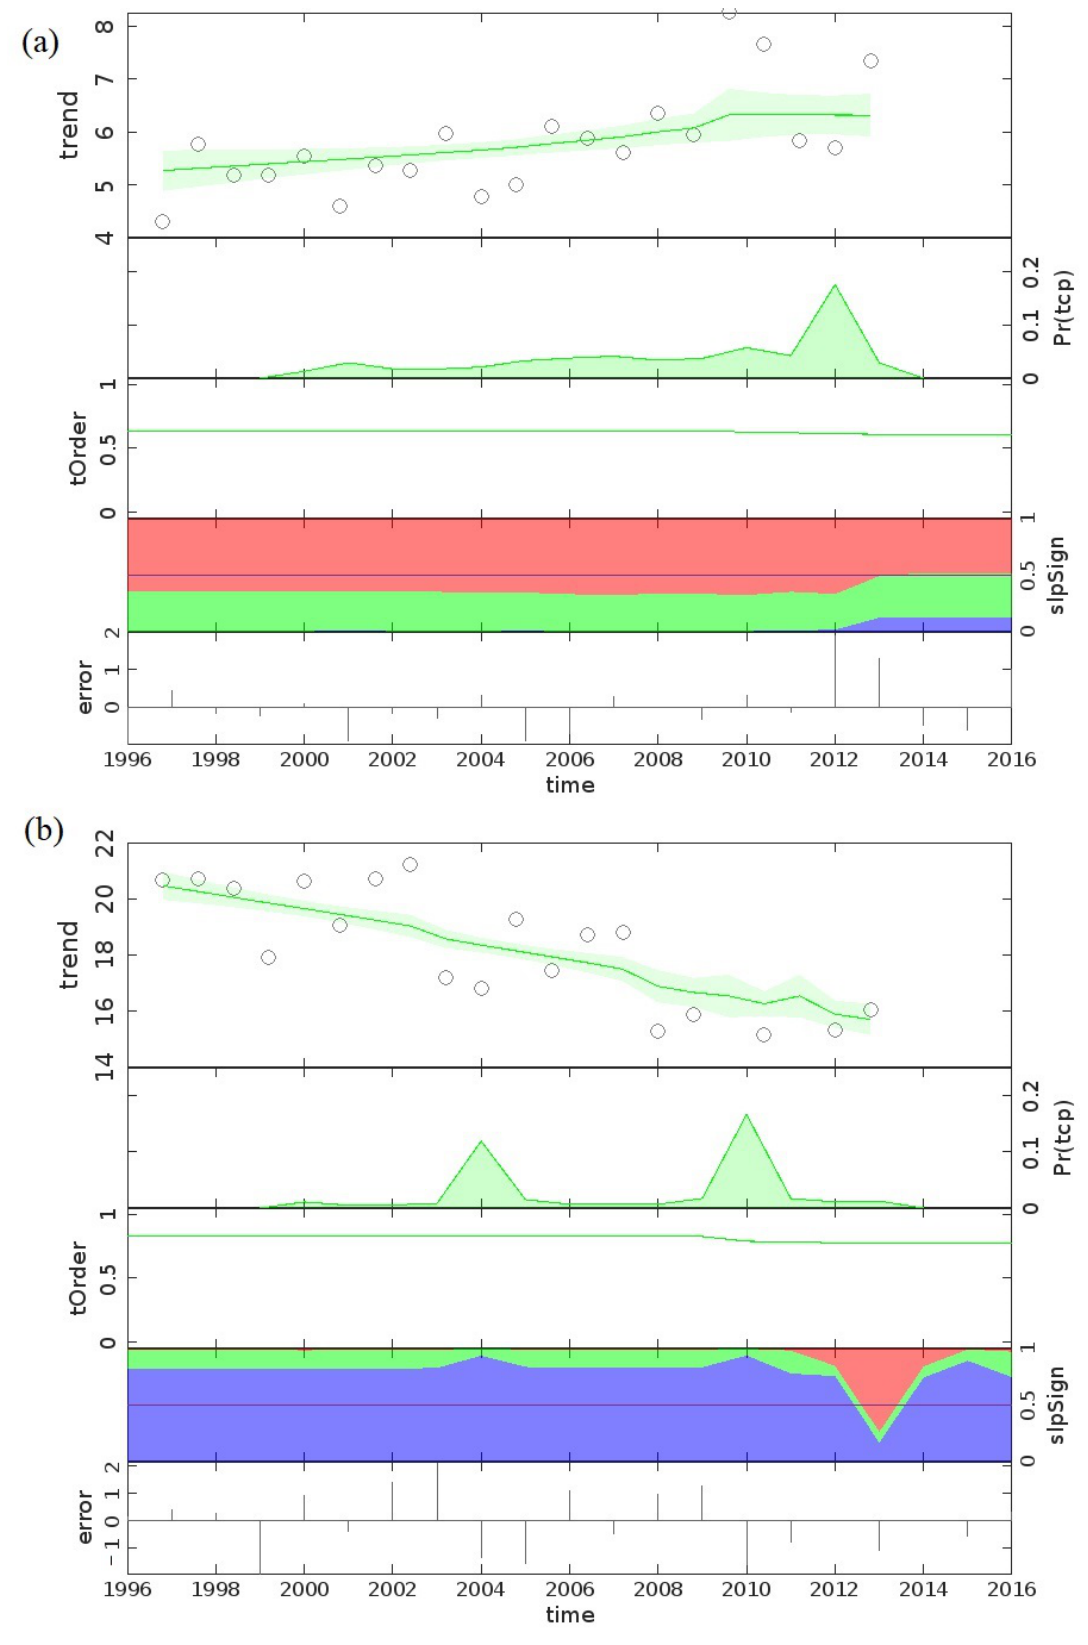
Figure 7. BEAST plot specifically for well locations ( a ) Pattambi and ( b ) Poonkulam.